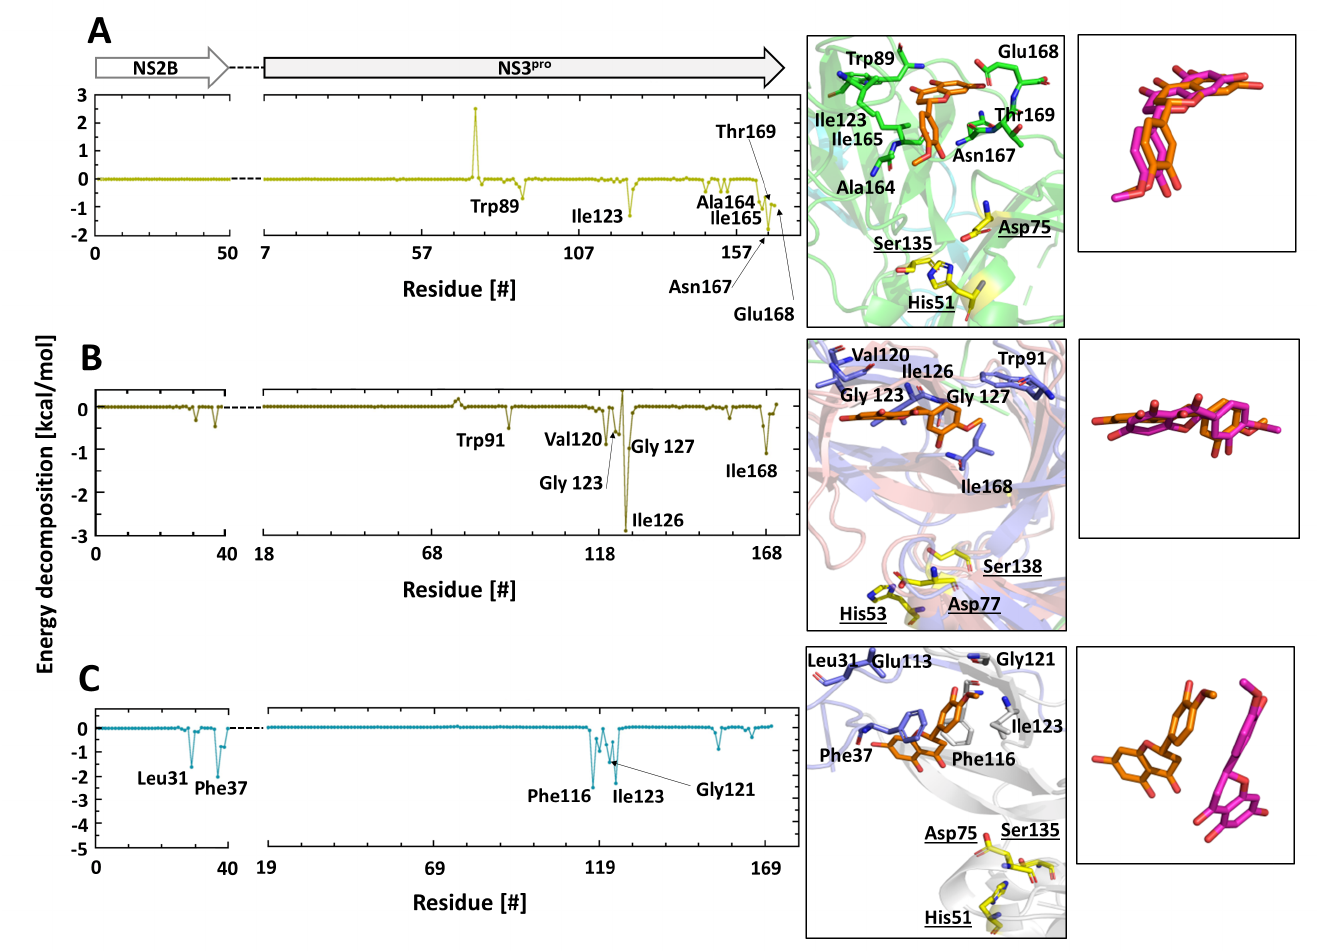
Figure 5. Amino acids contributing in the DENV2, YFV, and WNV NS2B/NS3 pro –HST interaction. Decomposition energy of the amino acids that participated in the interaction with HST is based on the MD simulations. Coordination of HST in the protease binding region and overlay of the HST replicas 1 and 2: ( A ) DENV2 NS2B/NS3 pro –HST interaction; ( B ) YFV NS2B/NS3 pro –HST interaction; ( C ) WNV NS2B/NS3 pro –HST interaction. Amino acid residues with an energy decomposition < − 1 kcal/mol are